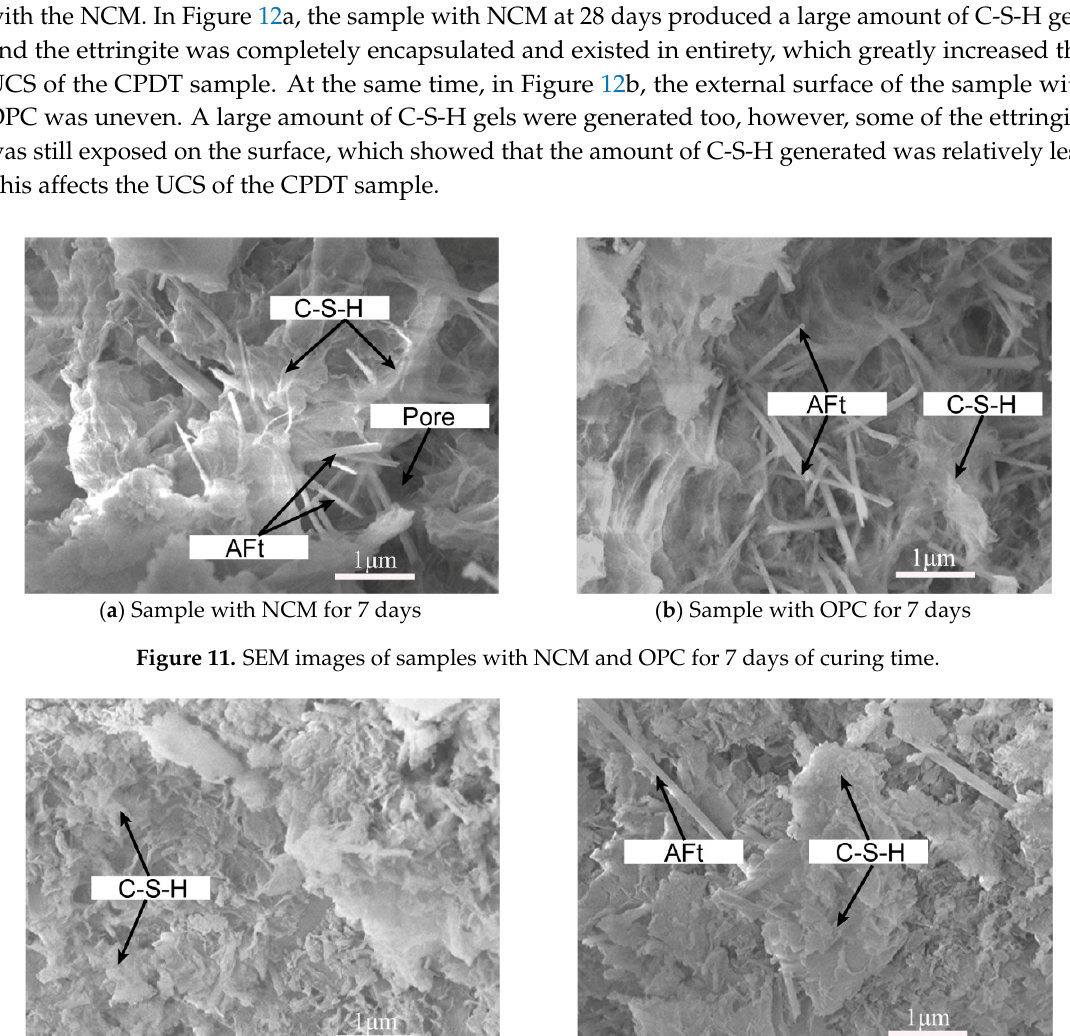
Figure 12. SEM images of NCM and OPC samples for 28 days of curing time.